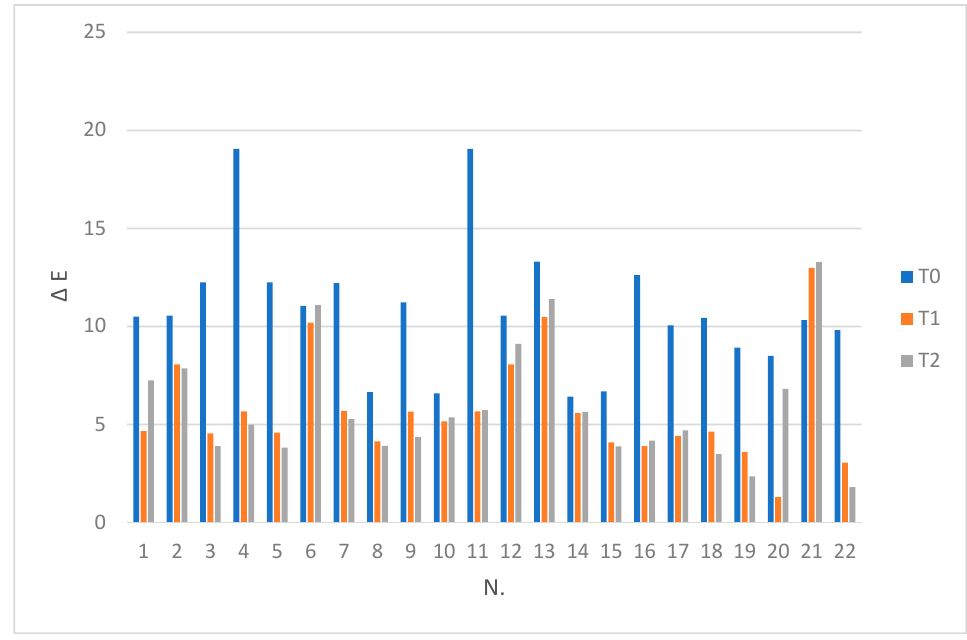
Figure 1. Δ E (WSL vs. SAE) at T0, T1, and T2 for each patient. Figure 1. ∆ E (WSL vs. SAE) at T0, T1, and T2 for each